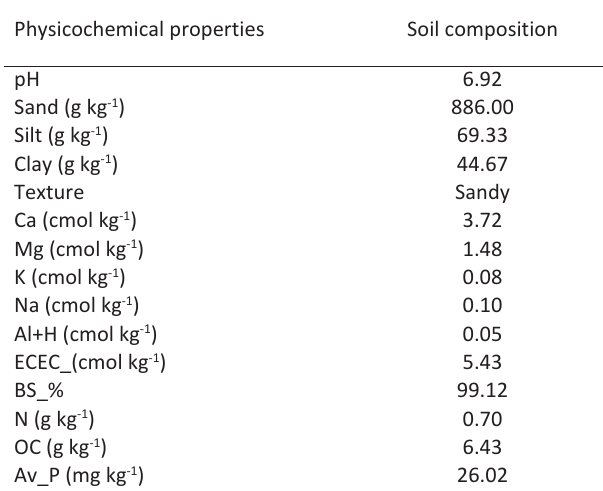
Table 1 ­ Pre­experimental characteristics of soil Physicochemical